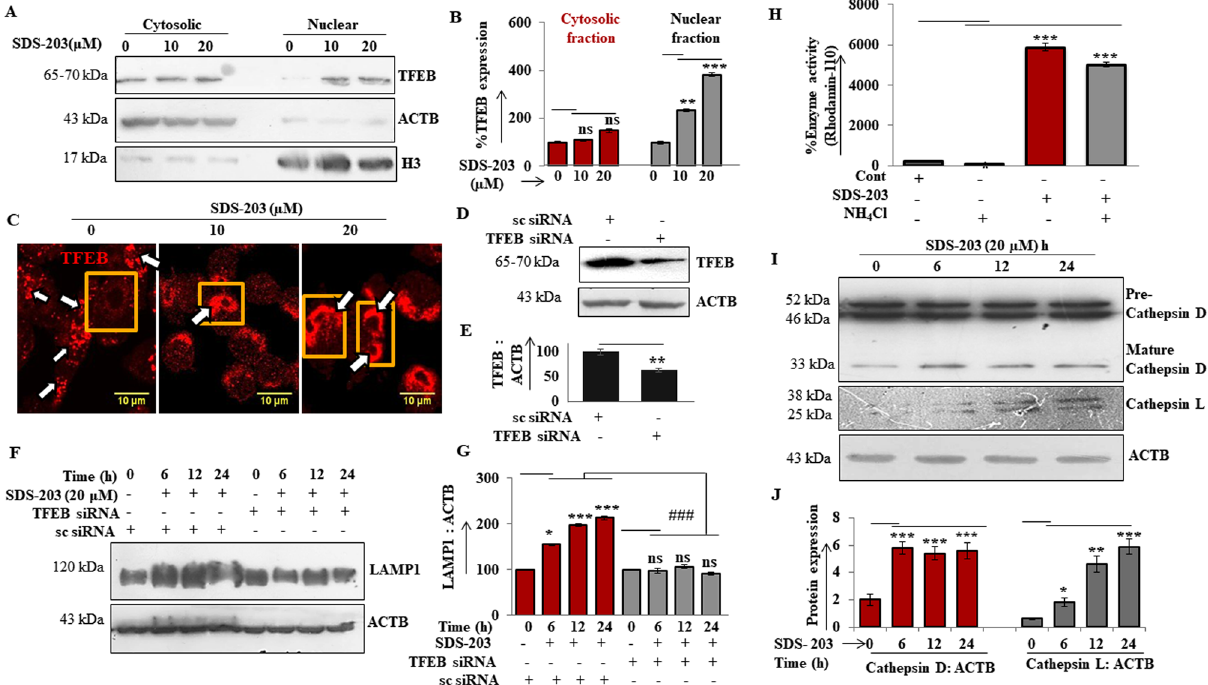
Figure 7. TFEB translocation and lysosomal enzyme activation upon suppression of mTORC1 by SDS- 203 treatment. ( A , B ) Western blot representation and band quantification of TFEB protein expression in cytosolic and nuclear fraction of MIA PaCA-2 samples treated with SDS-203 (0, 10, 20 µM) for 24 h. ( C ) confocal image representation showing TFEB nuclear translocation upon SDS-203 treatment (0, 10, 20 µM) for 24 h in MIA PaCa-2 cells( D, E ) Western blot illustration of TFEB knockdown i n MIA PaCa-2 cells and its densitometric quantification. ( F, G ) shows western blot for LAMP1 expression upon SDS-203 treatment in TFEB Knockdown (siRNA) and TFEB scramble g MIA PaCa-2 cells and its densitometric quantification ( H ) Effect of SDS-203 on lysosomal activity: MIA PaCa-2 cells were treated with SDS-203 (20 µM) with or without NH 4 Cl, cell lysates were then subjected to measure lysosomal enzyme activity by analyzing rhodamin110 fluorescence. ( I ) Shows time course western blotting analysis and ( J ) densitometric quantification of lysosomal enzymes- cathepsin D/L in MIA PaCa-2 cells upon SDS-203 treatments. Protein fold change was quantified by using ImageJ software. Error bar indicates ± SEM. * p < 0.05, ** p < 0.01, ***or### p < 0.001 vs.